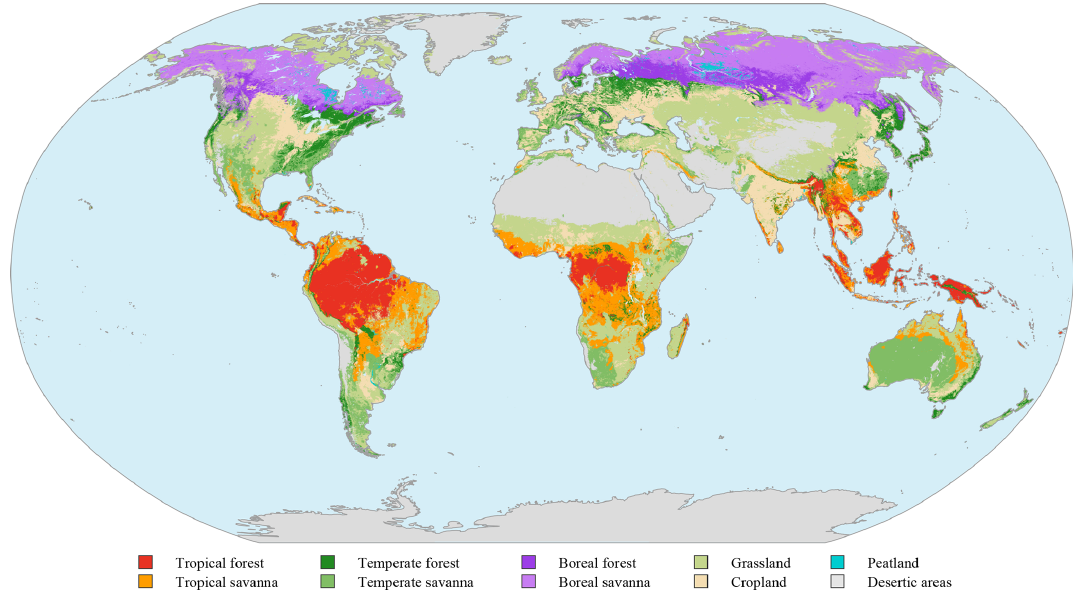
Figure 1. Biome map used in VFEI. Biomes were constrained using MODIS IGBP land categories and Köppen climate classifications following the criteria shown in Table 2.